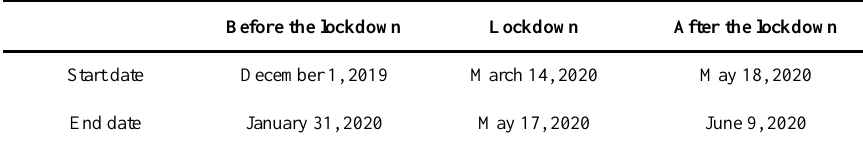
Table 1. Definition of periods of times analyzed for this study